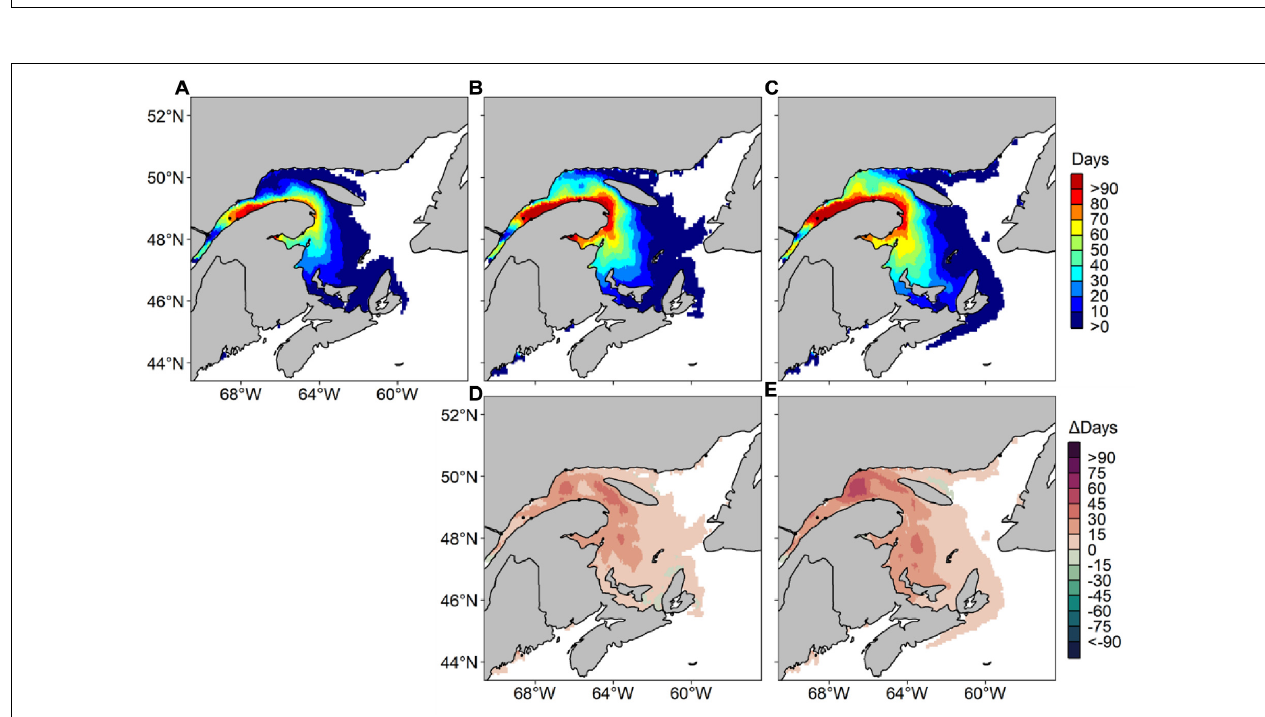
FIGURE 5 | Average number of risk days with Alexandrium catenella ≥ 1000 cells L − 1 from May through October along Canada’s East coast under MPI-ESM-LR RCP 4.5 for (A) 1999–2008, (B) 2050–2059, (C) 2090–2099 and difference in average number of risk days between (D) 1999–2008 and 2050–2059 and